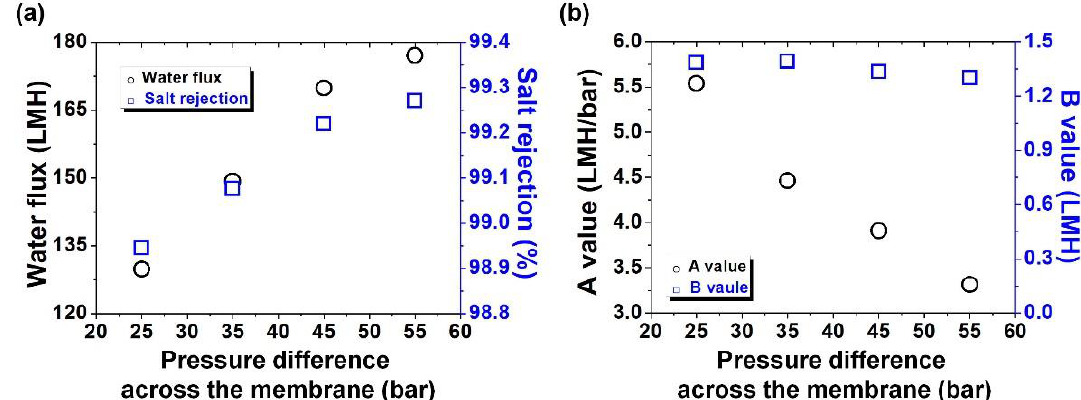
Figure 2. ( a ) Water flux and salt rejection and ( b ) water permeability and salt permeability coefficients of the TFC-D1 membrane at different applied pressures.